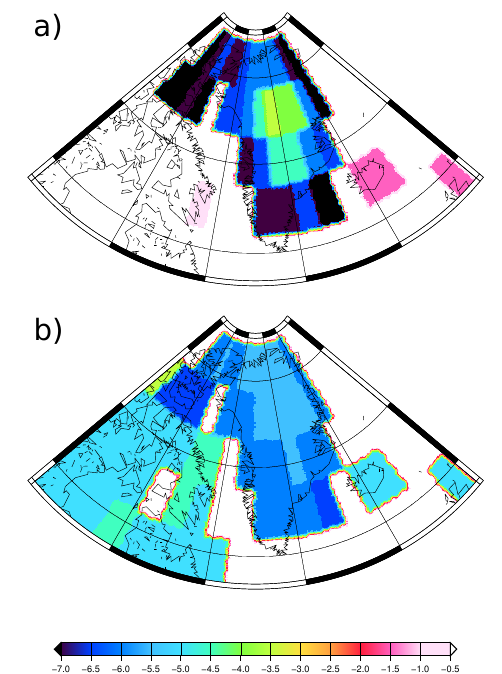
Figure 7. Calculated lapse rates within the downscaling procedure, in degrees per km. (a) is for February, (b) for July. Since the compu- tation of the lapse rate involves a linear regression over three tem- perature points, there is no lapse rate calculated when the correlation coefficient of the regression line is too low: hence the large white areas over North America in panel (a) . The orange line at the border is an artifact due to the mask computation and should be